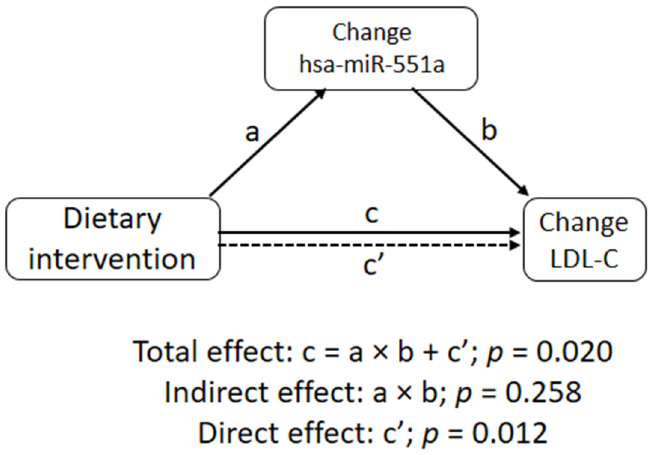
Figure 3. Schematic illustration of the mediation model conducted in the whole study population. Path c (total effect): β = − 0.1370, 95% confidence interval (CI) = − 0.23735; − 0.0201, p = 0.020; Path a: β = 0.1581, 95% CI = 0.04389; 0.2787; p = 0.007; Path b: β = 0.0742, 95% CI = − 0.03902; 0.1756, p = 0.212; Path a × b (indirect effect, mediation): β = 0.0117, 95% CI = − 0.00806; 0.0301, p = 0.258; Path c’ (direct effect): β = − 0.1487, 95% CI − 0.24925; − 0.0302, p = 0.012.